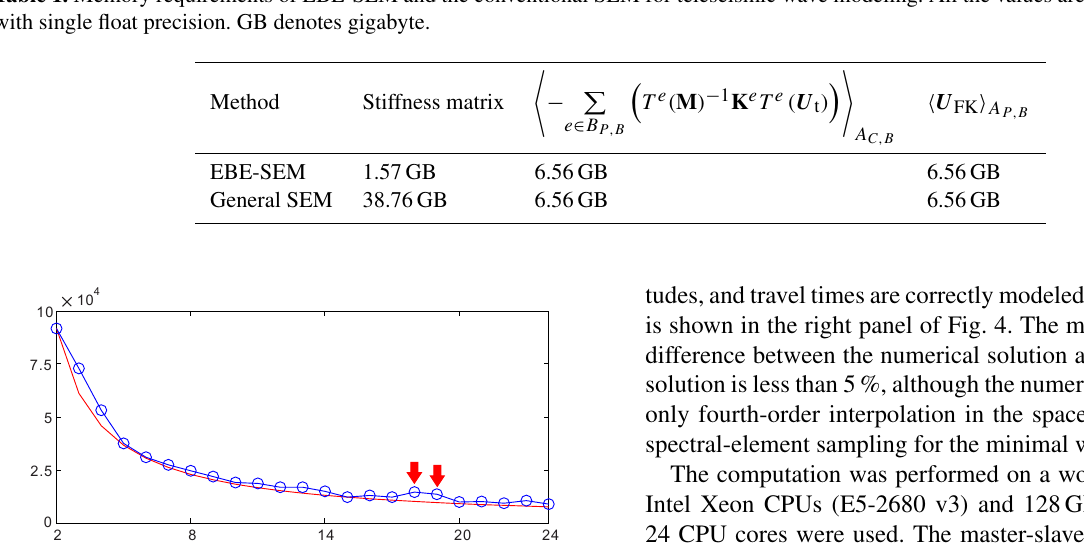
Figure 5. Parallel efficiency of the EBE-SEM. The red line denotes the theoretical CPU time, and the blue line with circles represents the actual CPU times. The red arrows designate the abnormal CPU times compared with the neighboring CPU times. Table 2. Material parameters of the crust–upper-mantle